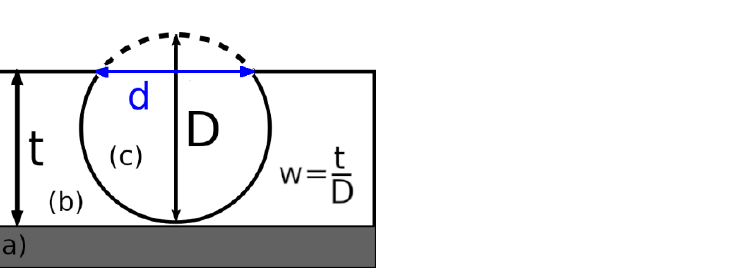
Table 2. XPS data valence states of the Ag for the films deposited using rhodanic and sulfite elec- trolytes.